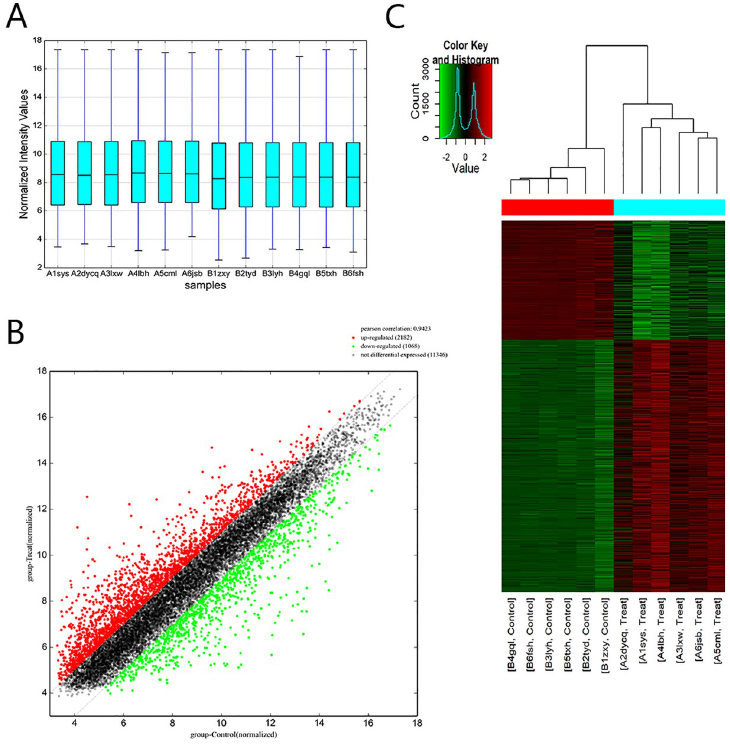
Fig 1. Comparison of mRNA expression profiles between the TAD samples and NT samples. Comparison of mRNA expression profiles between the TAD samples and NT samples. (A) The box plot is a convenient method to quickly compare the distribution of mRNAs. After normalization, the distributions of log2 ratios among the tested samples were almost similar. (B) The scatterplot is a visualization method that is useful for assessing the variation between TAD and control tissues compared by microarrays. The values of the X and Y axes in the scatterplot are averaged normalized values in each group (log 2 scaled). The green plot shows a decrease, and the red plot shows an increase in different genes. (C) Differentially expressed genes can be effectively divided into the TAD and NT groups. Red indicates that the gene that is upregulated, and green represents downregulated genes.